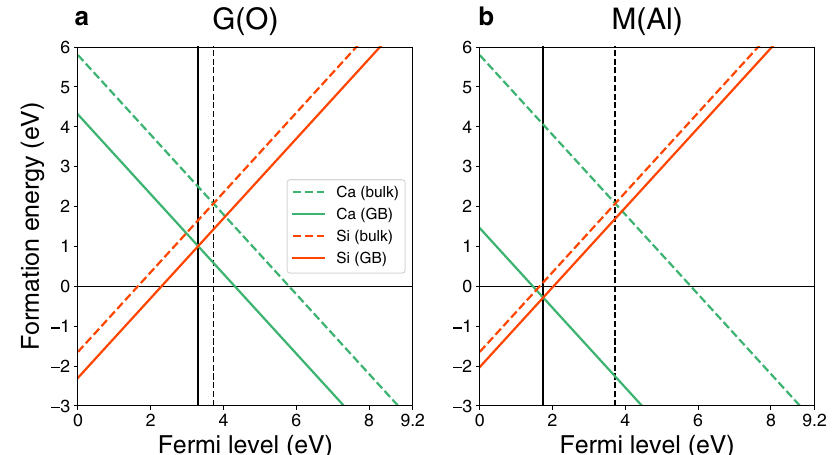
Fig. 4 | Thedefect formation energiesofCaandSiinbulk(dashed lines)and at the Σ 13 α -Al 2 O 3 GB. Defect formation energies at a G(O) and b M(Al) GB structures (solid lines) as a function of Fermi level, respectively. The Ca and